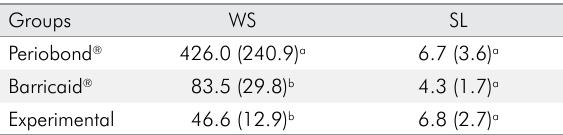
Table 2. Water sorption and solubility, mean and standard deviation in µg/mm 3 (n = 10).